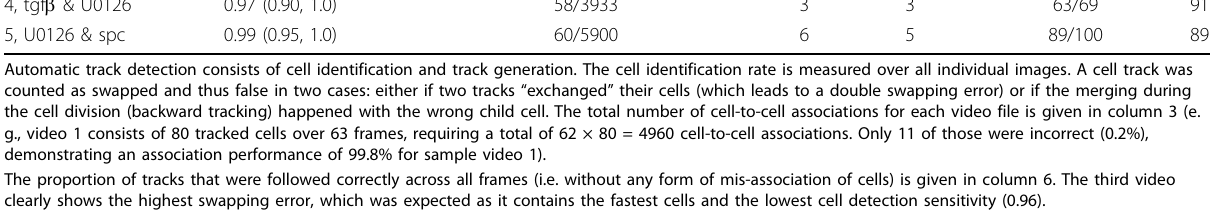
Cell detection rate median (min, max)